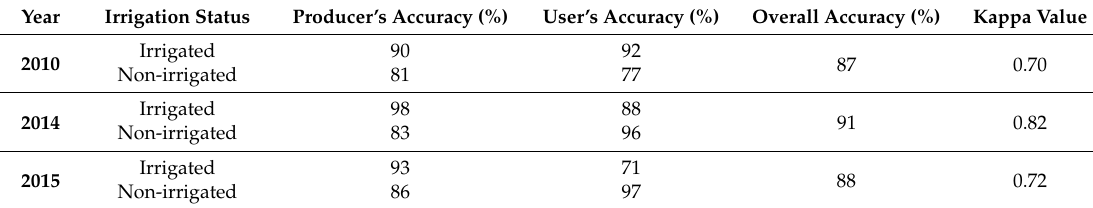
Table 1. Results of error matrix and Kappa analysis between NEG scheme and groundtruth data from the 2010, 2014, and 2015 growing